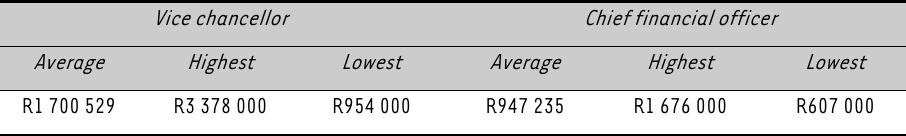
TABLE 8: Remuneration of executive